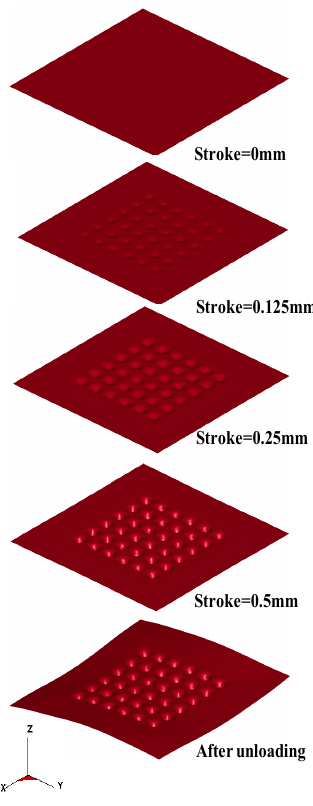
Figure 5. The geometric deformation of thin metal sheet against various strokes.